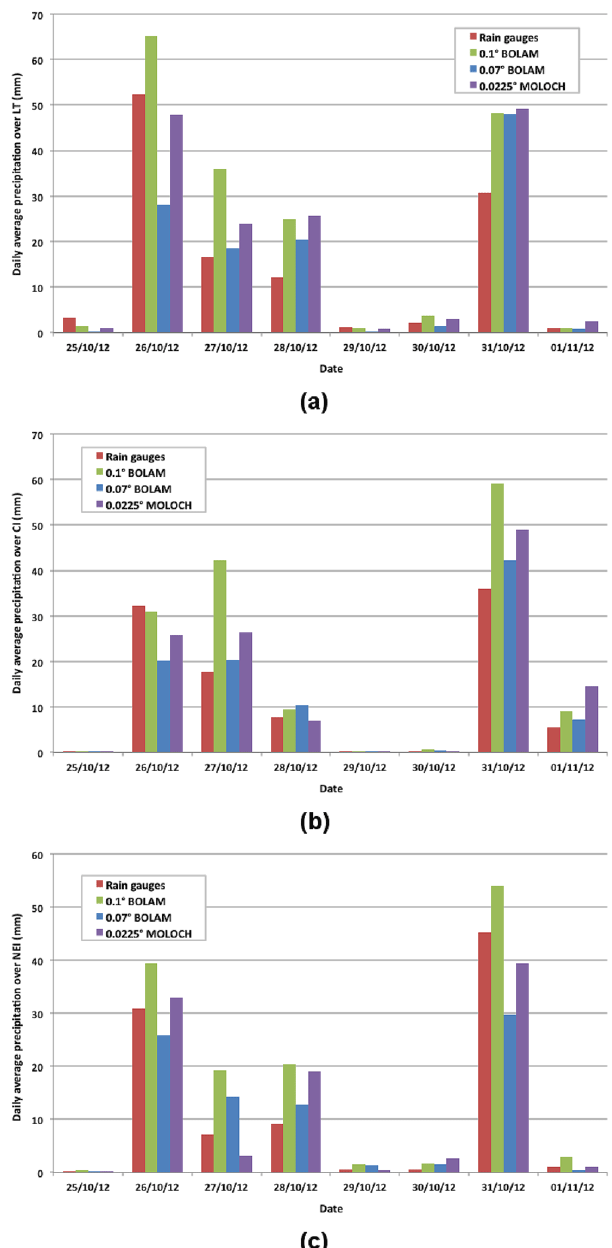
Figure 6. Comparison between the daily rainfall observations and the daily precipitation fields generated by the tree inter-compared meteorological models. The time series are averaged over three se- lected areas: (a) LT; (b) CI; and (c)